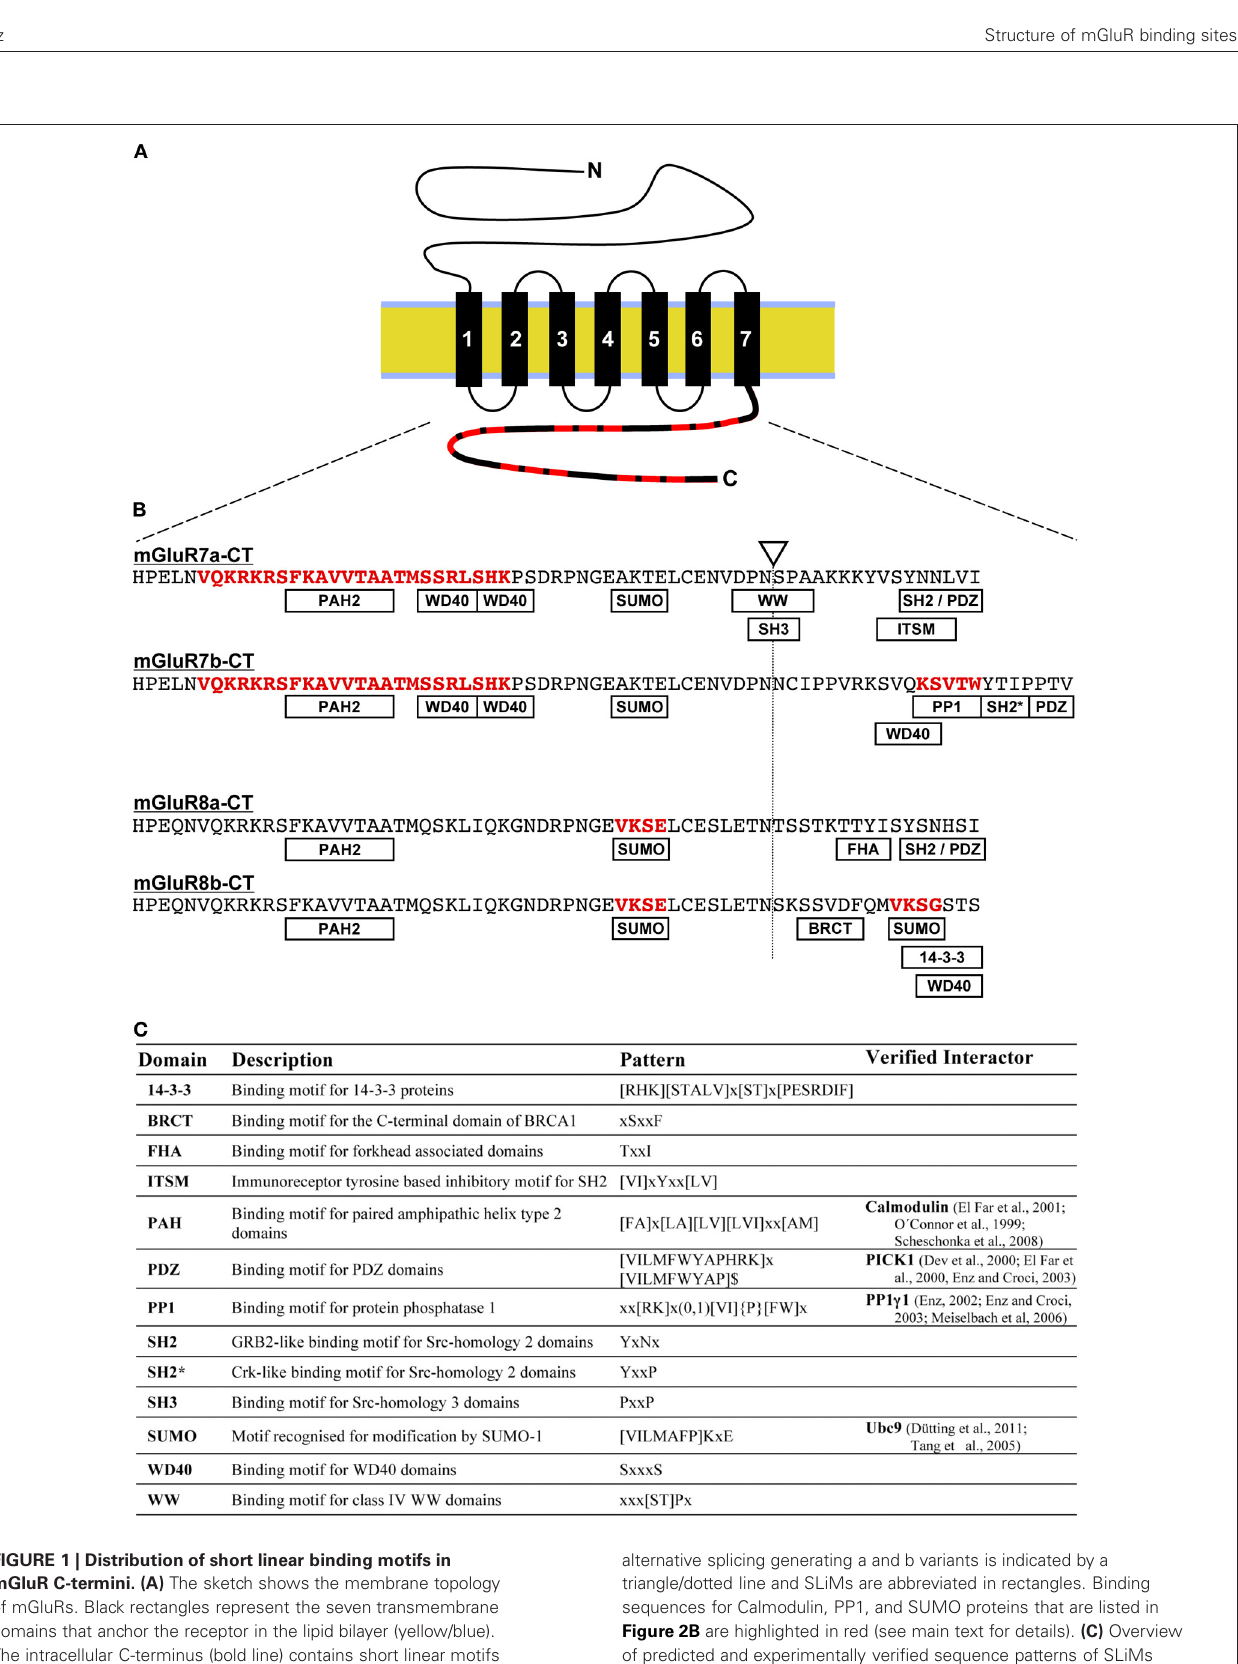
FIGURE 1 | Distribution of short linear binding motifs in mGluR C-termini. (A) The sketch shows the membrane topology of mGluRs. Black rectangles represent the seven transmembrane domains that anchor the receptor in the lipid bilayer (yellow/blue). The intracellular C-terminus (bold line) contains short linear motifs (SLiMs) that function as interaction sites for intracellular proteins (indicated in red). (B) Amino acid sequences of mGluR7 and mGluR8 C-terminal domains are shown in the single letter code. The site for